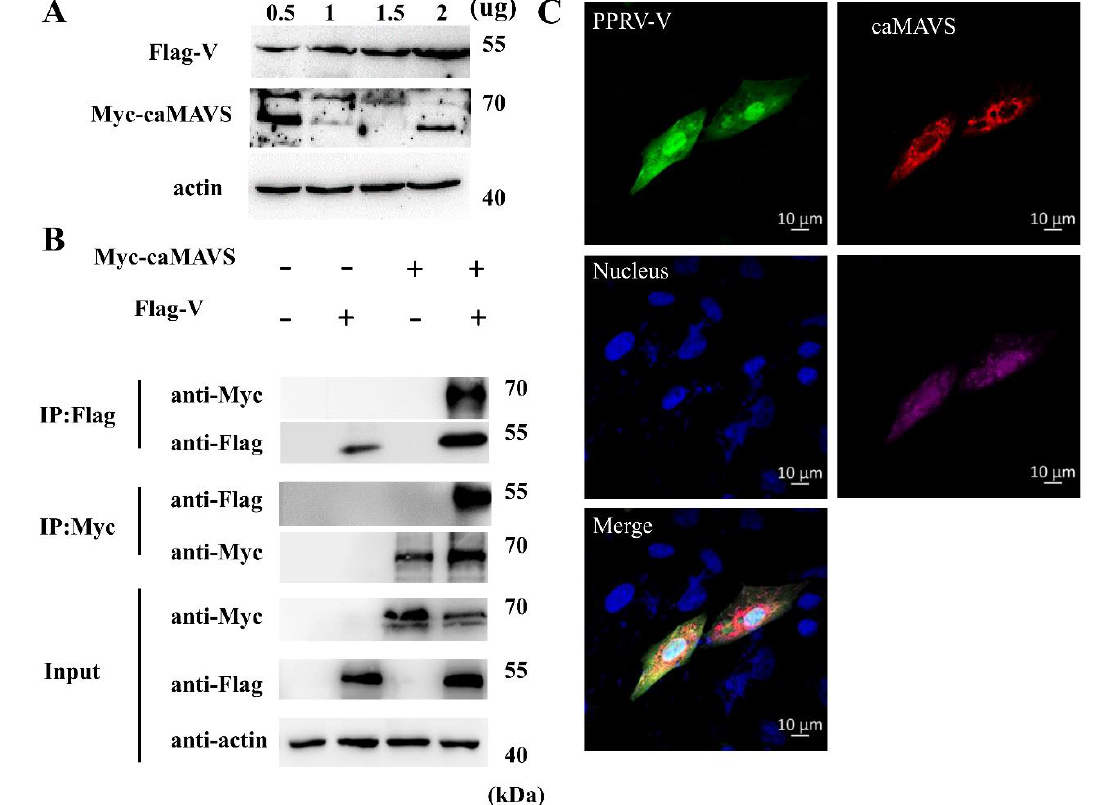
Figure 8. caMAVS interacts and colocalizes with PPRV viral protein V. ( A ) Increasing amounts of plasmids encoding Flag- tagged PPEV protein V (Flag-V) (0.5 ug, 1 ug, 1.5 ug, 2 ug) were co-transfected with plasmid-encoding Myc-tagged caMAVS (2 ug) in 6-well plates. PPRV V and caMAVS were detected by Western blot using β -actin as loading control. ( B ) Co-IP was performed to identify interaction between PPRV V and caMAVS. Flag-V and Myc-caMAVS plasmids were transfected into HEK-293T cells independently or together. Cell lysates were subjected to immunoprecipitation with anti-Myc or anti-Flag mAb overnight at 4 ◦ C. The expression of the transfected proteins was determined by Western blotting by anti-Flag and anti-Myc mAbs, respectively. ( C ) The colocalization study was performed by transfection of Myc-caMAVS (red), Flag-V (green) together with pDsRed2-Mito (pink) and subjected for IFA with anti-Flag and anti-Myc mAbs as primary antibodies.